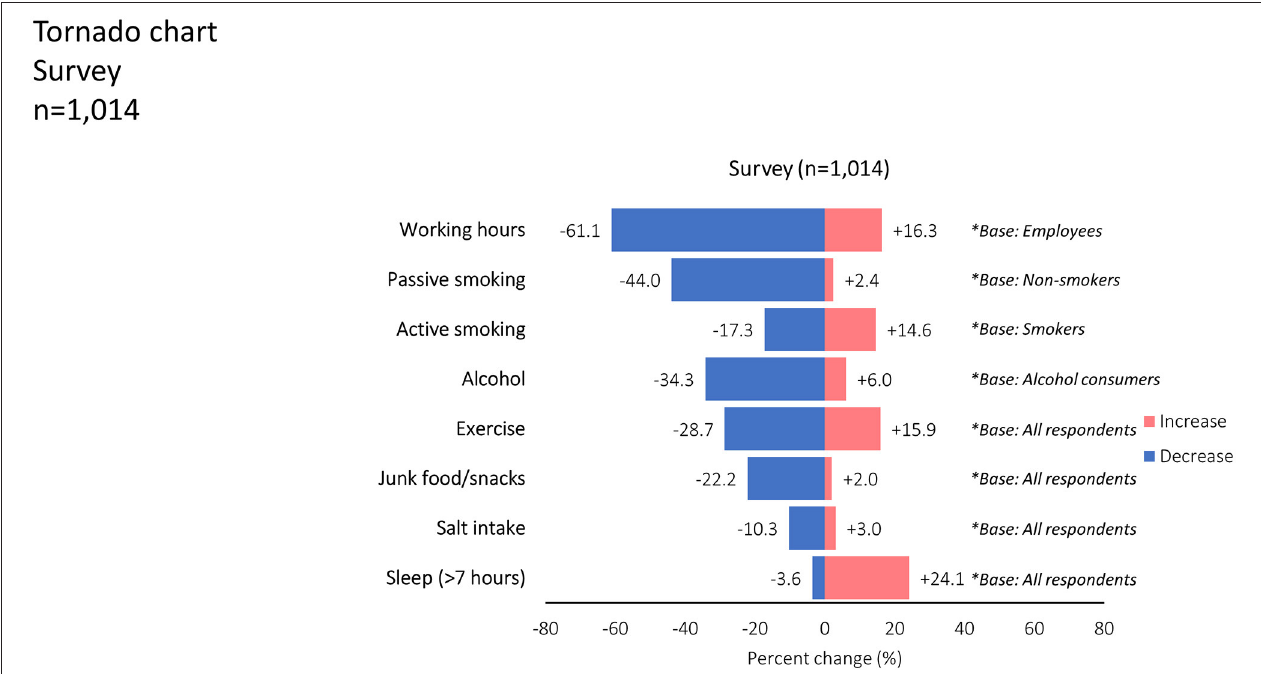
FIGURE 4 | Tornado chart demonstrates the reported changes in various lifestyle variables ( P : 0.000 in all cases except active smoking). Blue bars extending to the left-hand side refer to a decrease, whereas red bars on the right-hand side refer to an increase in the reported frequency of the lifestyle